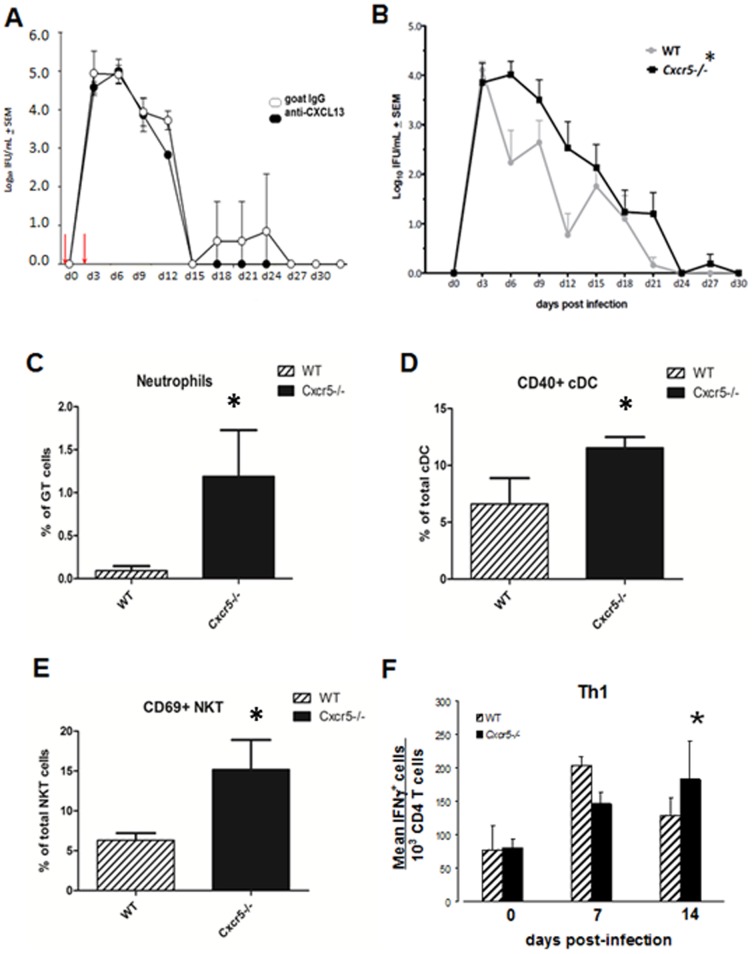
Disruption of the CXCL13-CXCR5 axis alters bacterial burden in Cxcr5−/− mice.Vaginal swabs were collected throughout the course of infection in BALB/c mice given i.p. injections (day −1 and 2, red arrow) of anti-CXCL13 Ab or irrelevant control Ab. Not significant by 2-way repeated measures ANOVA, n = 3/grp. (B) Vaginal swabs were collected throughout the course of infection in Cxcr5−/− and WT mice. *p<0.05 by 2-way repeated measures ANOVA, n = 11/grp. Experiments were and repeated 5 times. (C–E) Single cell suspensions of whole GT lymphocytes were stained for flow cytometric identification of neutrophils (Gr-1+ & CD11b+); cDC (CD11c+, CD11b+, CD3−, CD19− CD40+) and activated NKT cells (α-GalCer tetramer, NK1.1+, CD3+; CD69+). Dotplots were gated on singlet lymphocytes and the above markers. Bar graphs show the percent of neutrophils, CD40+cDC and CD69+NKT over the indicted denominator ± SD in GT. *p<0.01 as determined by Bonferroni's t-test, n = 4 pools of two mice/group. (F) Mice were vaginally infected with C. muridarum and lymphocytes were isolated at various times following infection from the whole GT. Cells were stimulated ex vivo with PMA and ionomycin and characterized by flow cytometry. Dotplots were gated on CD3 and CD4. Bars show the mean frequency of Th1, IFNγ+ cells per group ± SD of 4 mice/group. *p<0.05 as determined by Bonferroni's modified t-test.